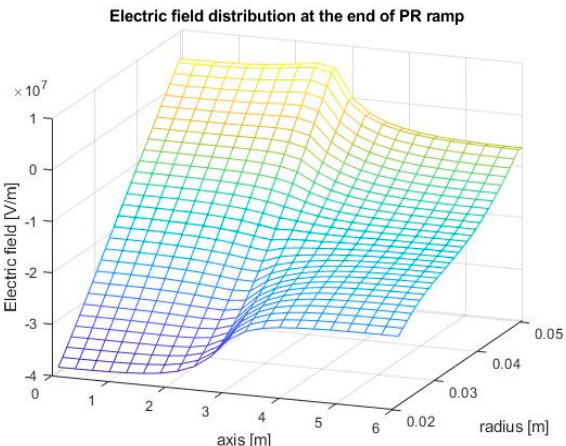
Figure 12. Electric field distribution at the end of the PR ramp—Scenario E.